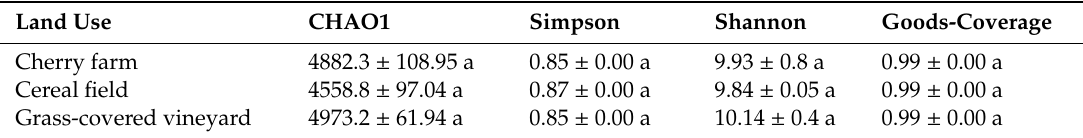
Table 8. Estimation of α -diversity indexes for bacterial communities under di ff erent land uses (sequence count: